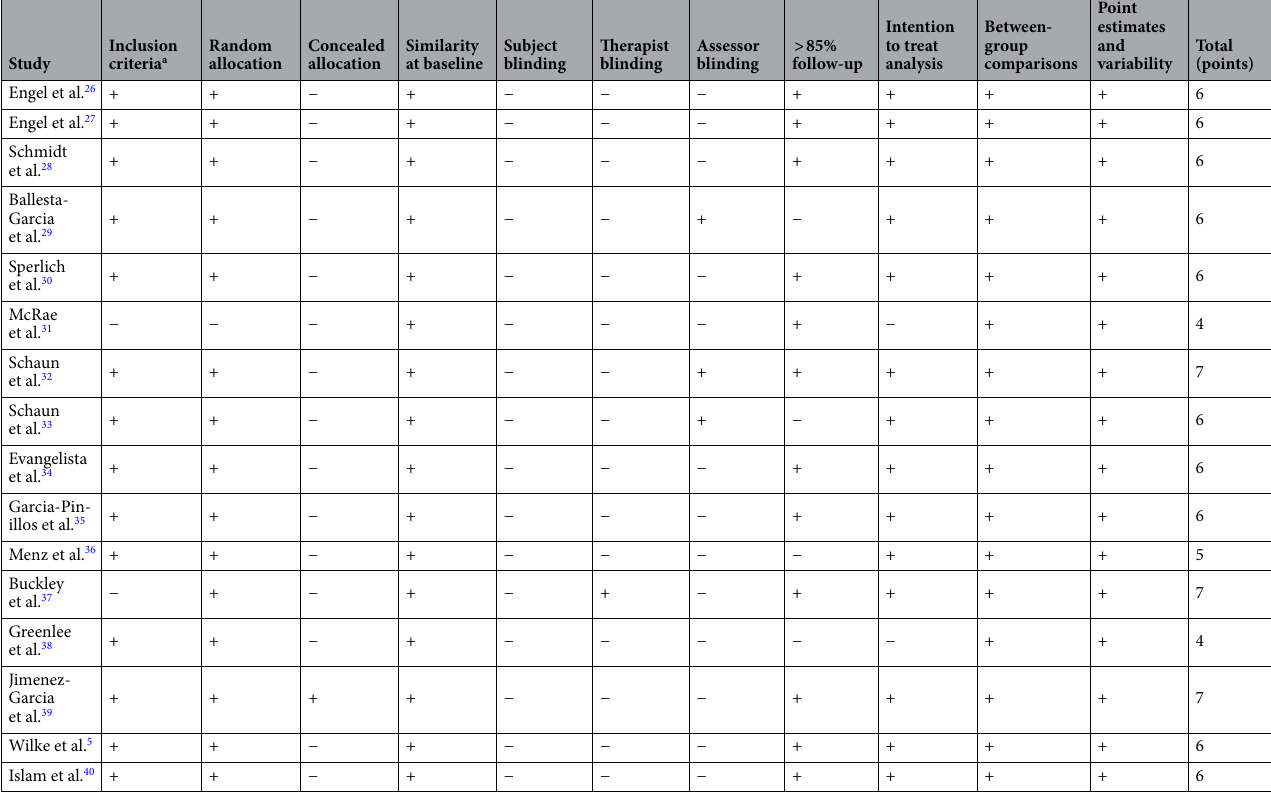
Table 2. Methodological quality of the studies included (ratings on the PEDro scale). a External validity, not counted for score, + = point awarded,− = no point